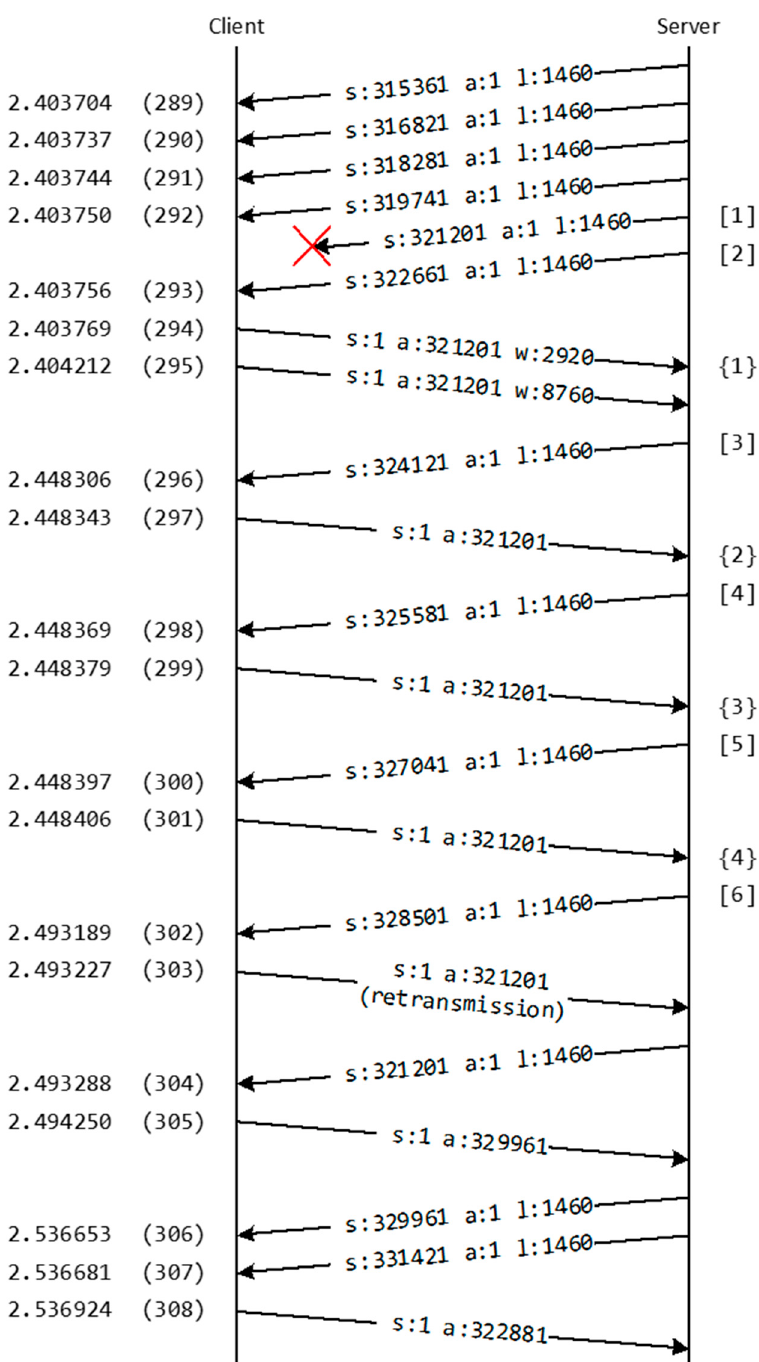
Figure 10. Packet Exchange for Packet Loss and Retransmission.